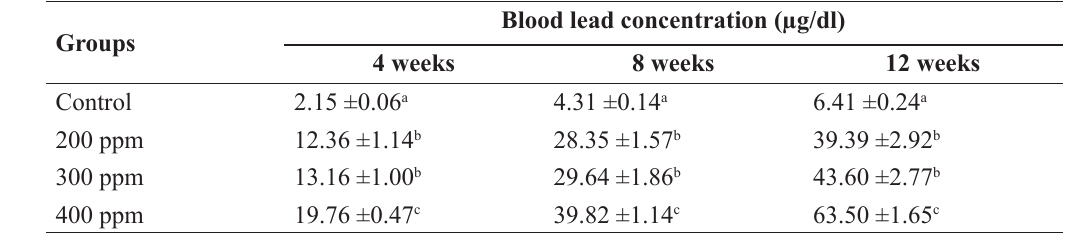
Table 1: The mean blood lead concentrations of male Albino rats treated with graded doses of lead for a period of four, eight and twelve